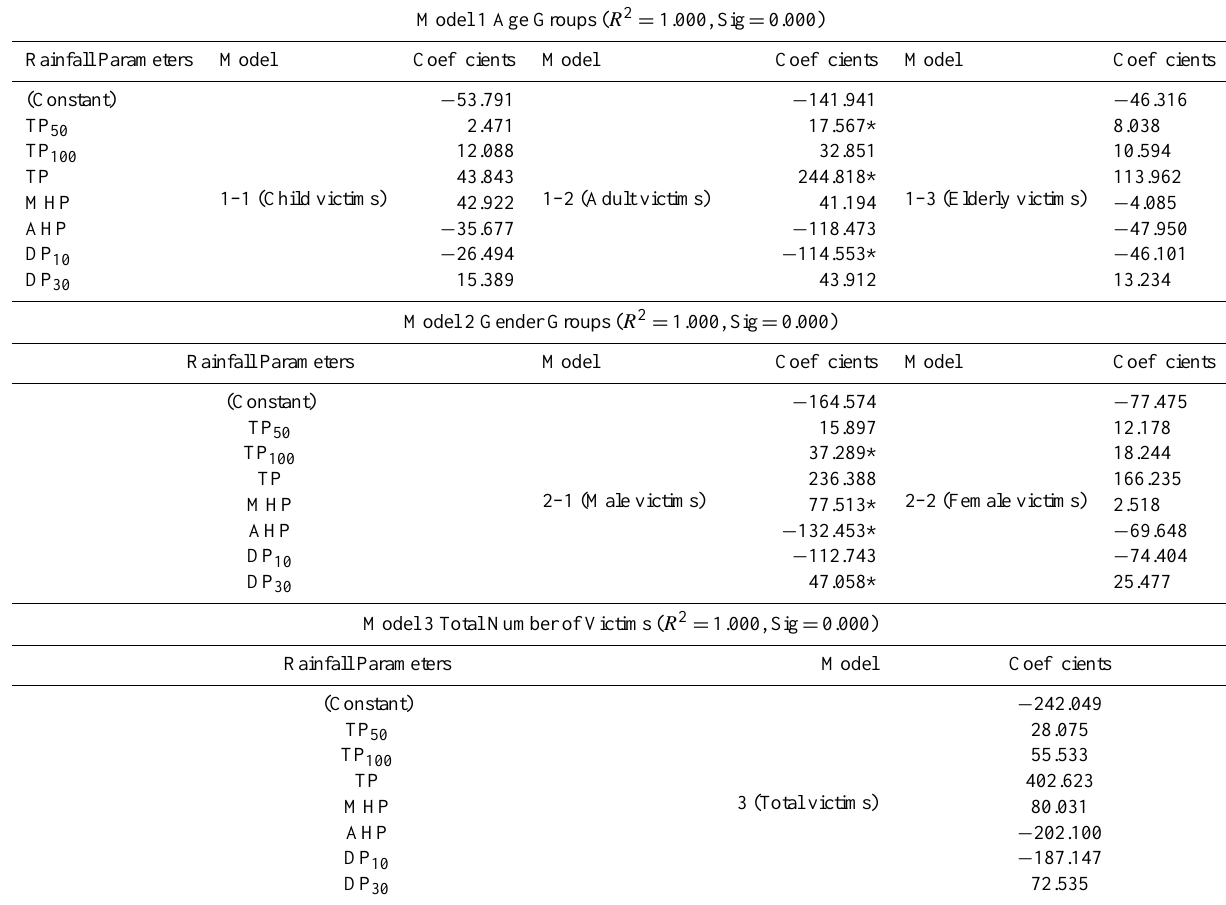
Table 4. Linear regression models of the impact of each extreme rainfall parameter on victims according to age groups (model 1), gender (model 2) and total number of victims (model